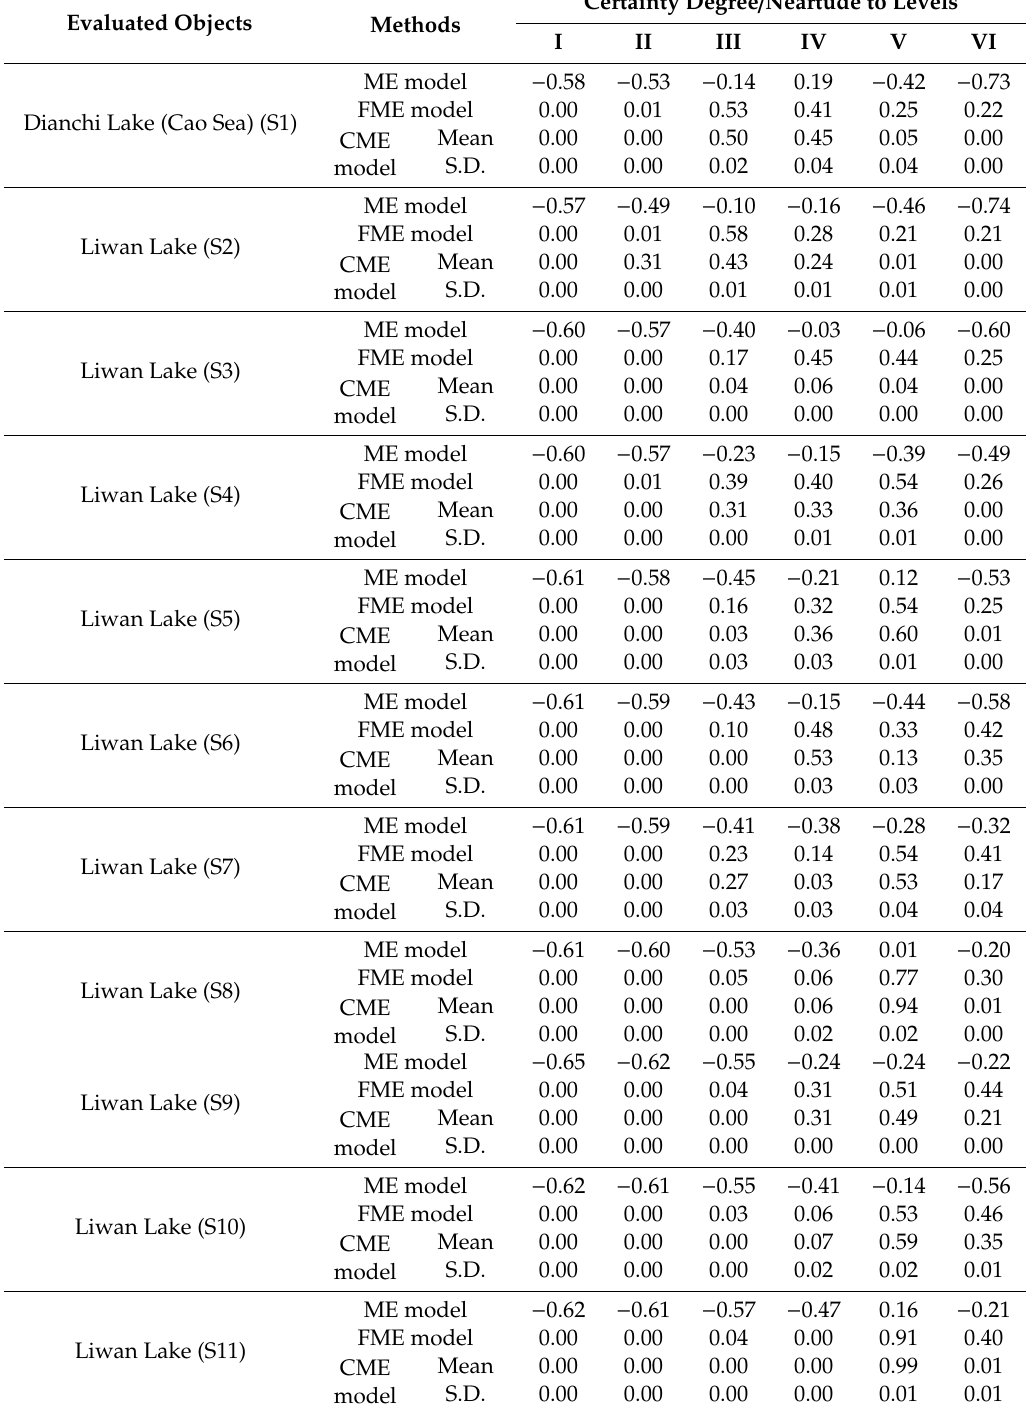
Table A1. The comparison of ME, FME, and CME for 24